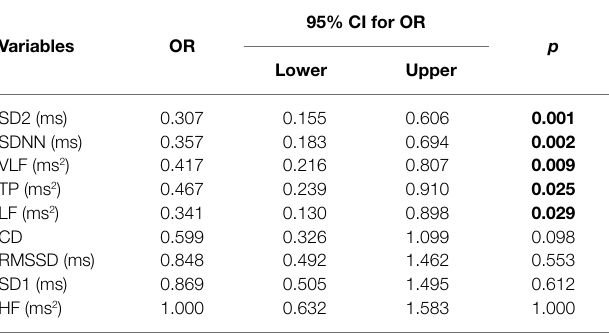
BMI, body mass index; CI, confidence interval; CD, correlation dimension; HF, high- frequency power; HR, heart rate; LF, low-frequency power; OR, odds ratio; RMSSD, root mean square of successive interval differences; RR, respiration rate; SD, standard deviation; SDNN, standard deviation of all normal-to-normal intervals; TP, total power; and VLF, very low frequency. Bold values of p indicate statistical significance (value of p <